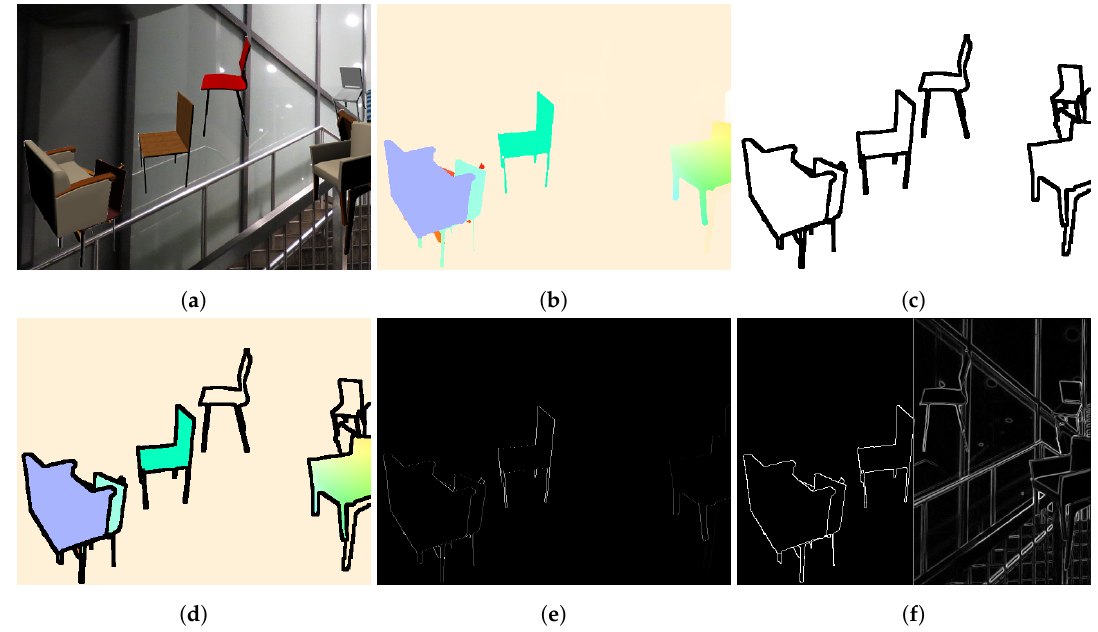
Figure 2. ( a ) Sample from FlyingChairs dataset. ( b ) Ground truth optical flow. ( c ) Corresponding M sem mask. ( d ) Overlay of M sem and GT flow. Notice how enclosed segments have a smooth flow. ( e ) Motion edges. Notice that it is concentrated on boundaries. ( f ) Comparison of semantic edges with a typical edge mask. Notice how they better correlate to motion